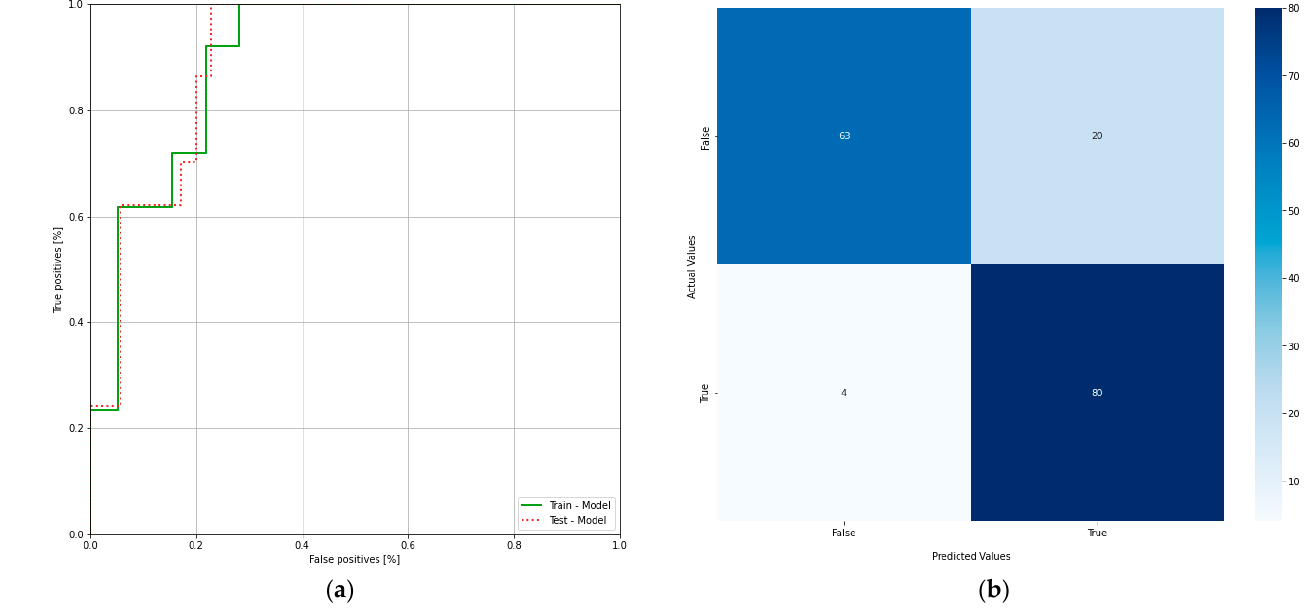
Figure 6. ( a ) Receiver operating characteristic curve of the clinical model; ( b ) confusion matrix of the clinical model.